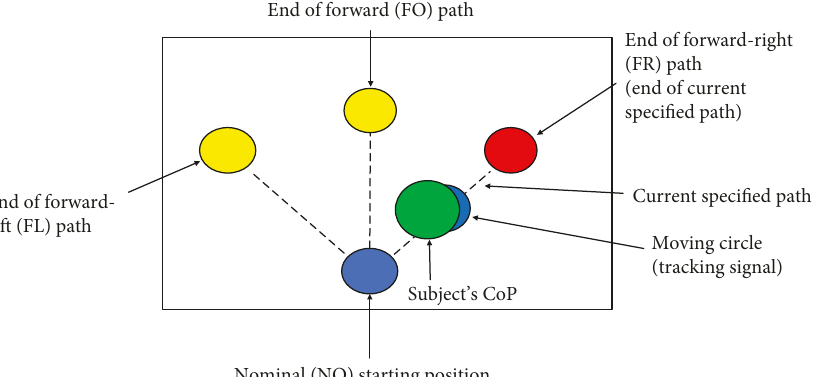
Figure 2: Diagram of the visual feedback display. The subject stood erect at the nominal (NO) starting position and adjusted the overall center of pressure (CoP) position to track the moving circle to the end of the paths de fi ned by the yellow circles. The subject tracked the moving circle along the same path to return to the NO position. Prior to conducting the experiments, the speed of the moving circle and the locations of the endpoints of the paths were tuned to ensure that the subject adjusted posture at a comfortable rate and within reasonable limits of his standing balance. During the experiments, the subject adjusted the overall CoP position (green) to track the moving circle (blue) in the forward (FO), forward-right (FR), and forward-left (FL) directions. As an additional visual cue, the currently speci fi ed path is de fi ned by changing the color of its endpoint from yellow to red. In this image, the currently speci fi ed path is the one from NO to